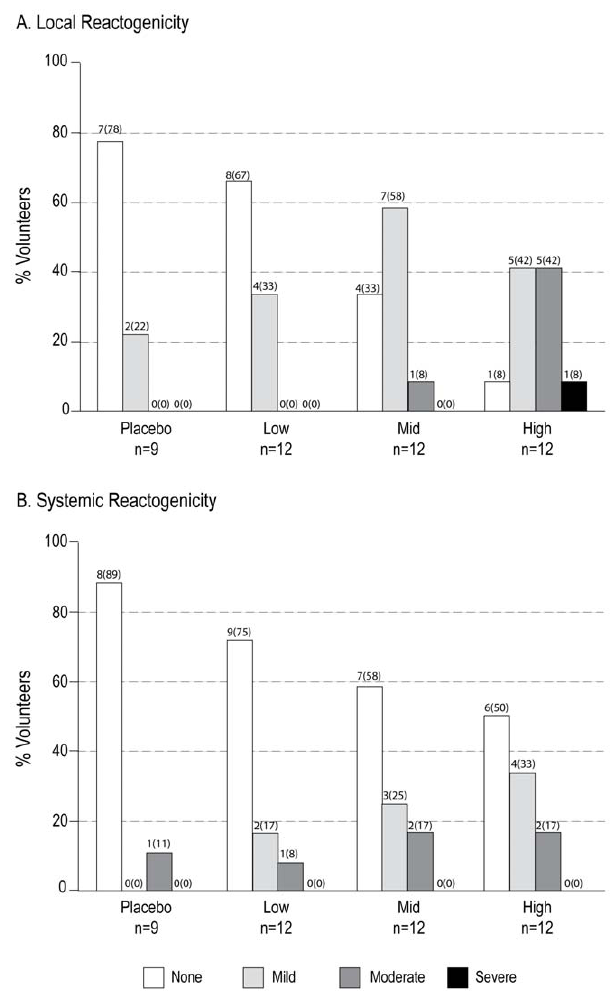
Figure 2. Local and Systemic Reactogenicity by Dosage Group. Panels A and B depict the percentage of volunteers experiencing local or systemic reactogenicity, respectively, by severity and dosage group. Total responses and (percentage of responses) are depicted above each bar. The proportion of volunteers experiencing moderate or severe local reactogenicity increased with increasing dosage (two-tailed Cochran- Armitage trend test, p=0.0040). A similar comparison of systemic reactogenicity was not statistically significant